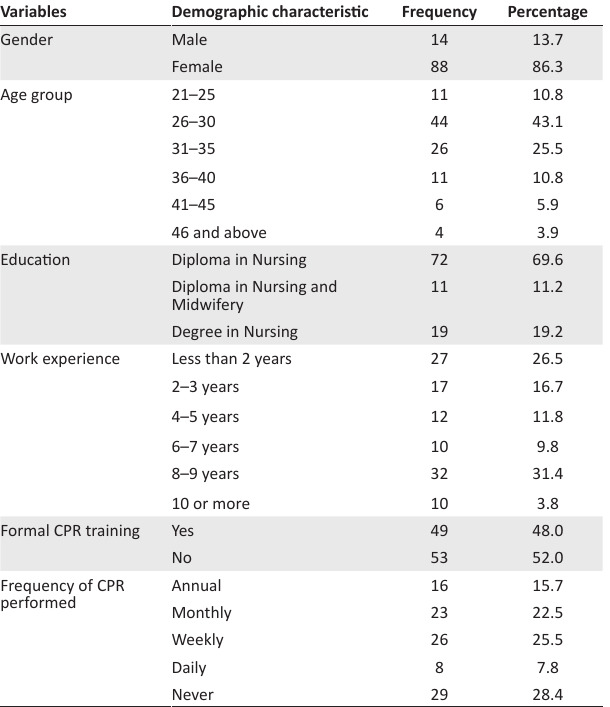
TABLE 1: Demographic and professional characteristics of registered nurses in two referral hospitals in Botswana ( N = 102). Variables Demographic